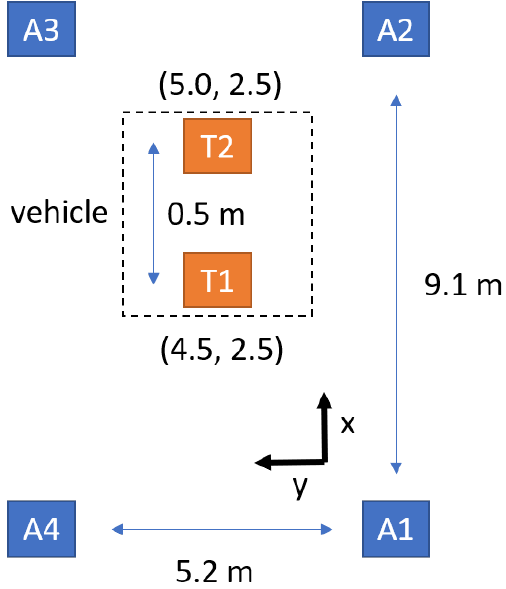
Figure 10. Setups for checking the estimated direction accuracy.